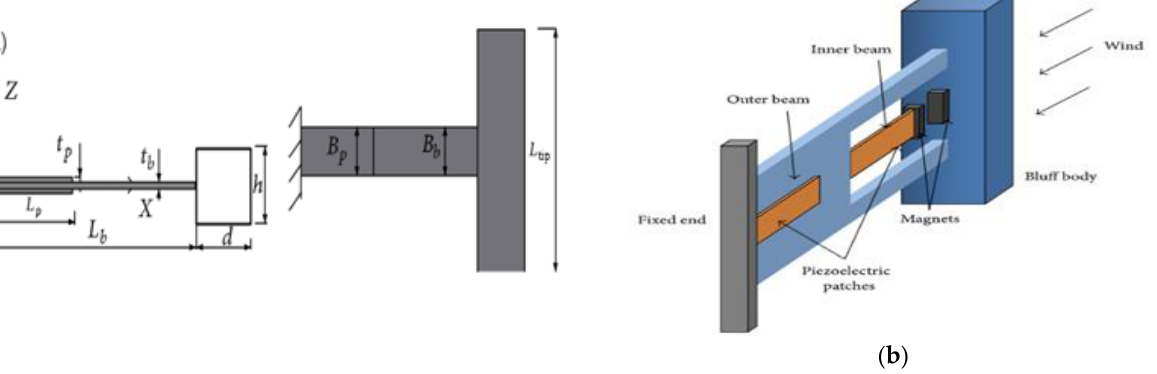
Figure 7. ( a ) Schematic of galloping with an energy harvester square bluff body; ( b ) at low wind speed, power enhancement through 2DOF piezoelectric galloping energy harvester [128].